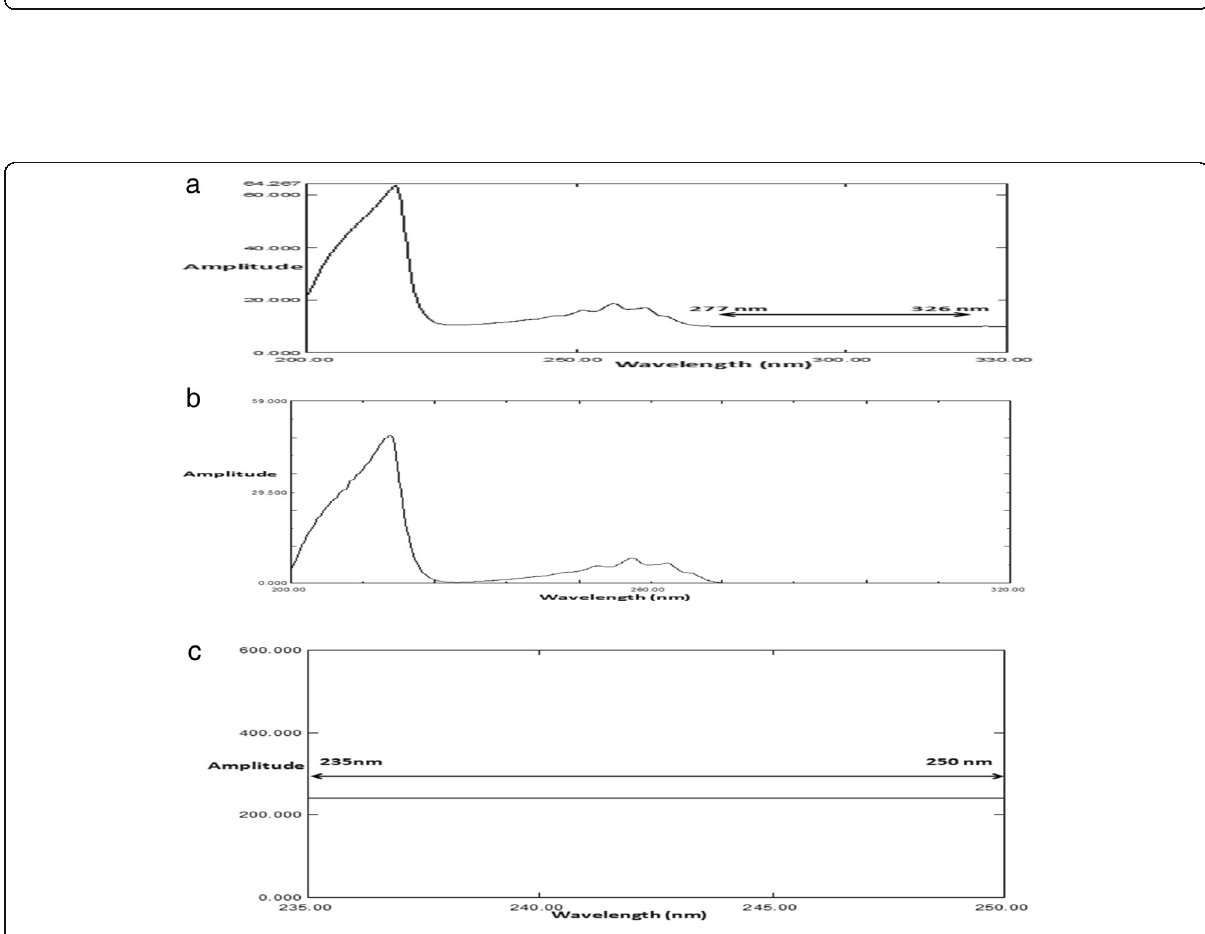
Fig. 7 a Ratio spectrum of binary mixture 240.0 μ g/mL of PSE and 10.0 μ g/mL of LOR using spectrum of normalized LOR ′ as a divisor showing the value of constant at (277 – 326 nm). b The obtained ratio spectrum of binary mixture after subtraction of the constant value. c The obtained ratio spectrum of binary mixture after multiplication by recovery spectrum (normalized spectrum of LOR/normalized spectrum of PSE) showing the value of constant at 235 – 250